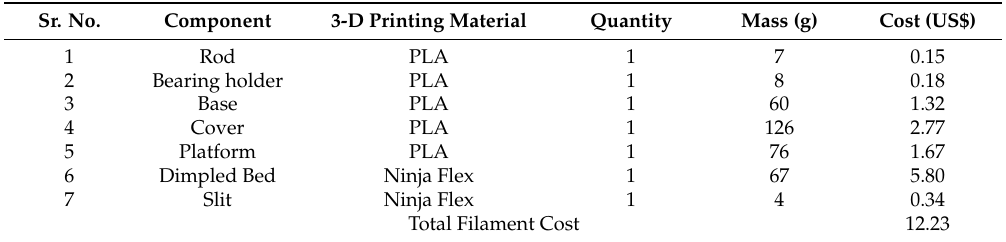
Table 1. Bill of materials (BOM) for three-dimensional (3-D) printed components including material, mass and cost.